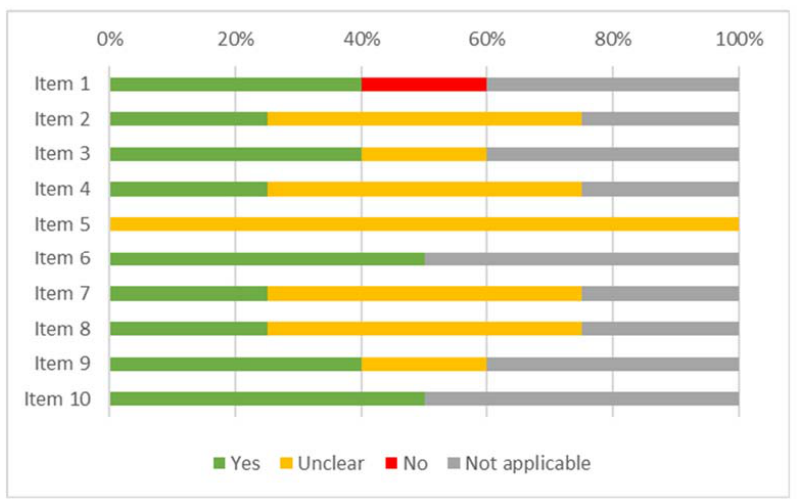
Figure 5. Summary of the critical appraisal process of the diagnostic accuracy of the studies ac ‐ cording to the JBI tools.